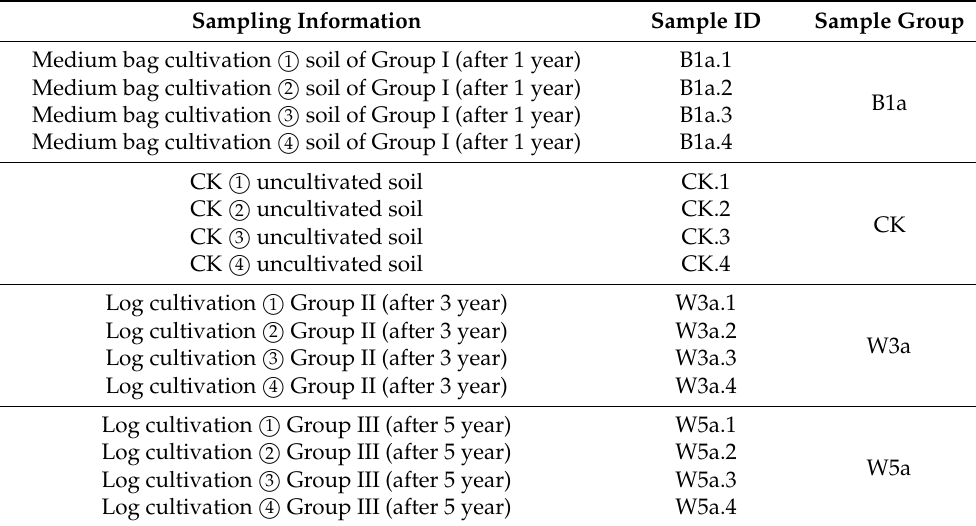
Table 1. Soil sampling information and sample